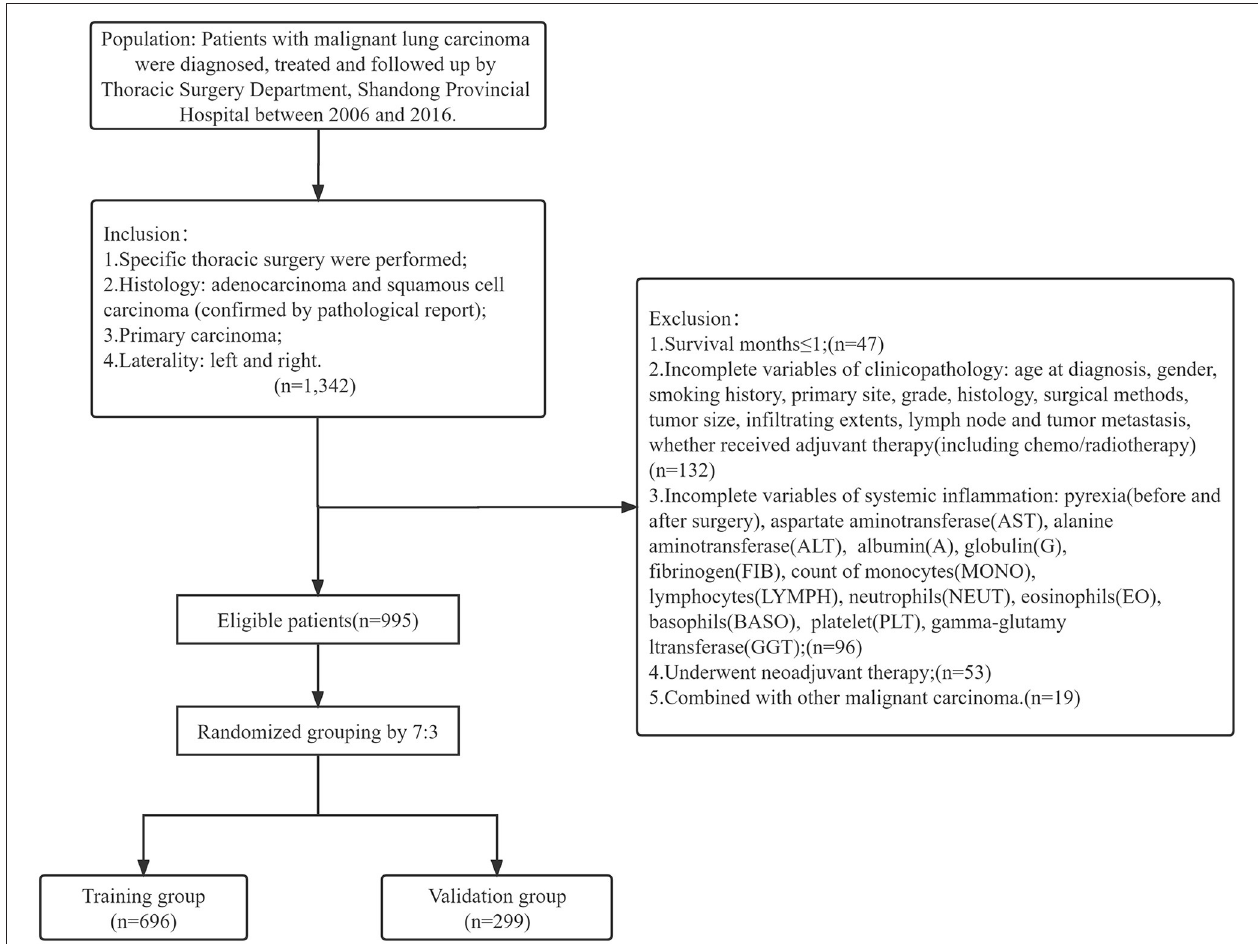
FIGURE 1 | Inclusion and exclusion criteria for training and validation group.